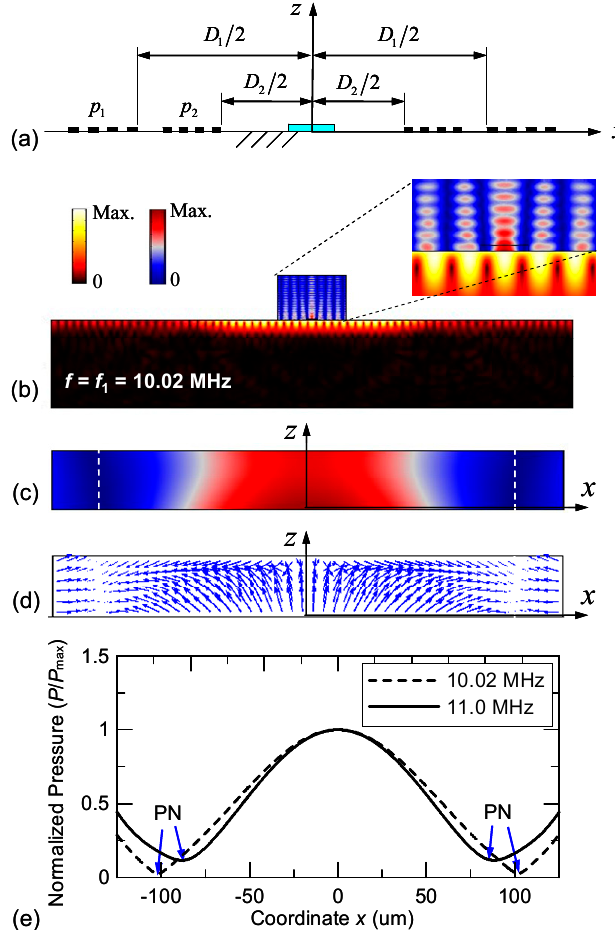
Figure 3. ( a ) Schematic of the symmetric two-pitch IDT arrangement on the surface of the LiNbO 3 substrate. The IDT pitches are p 1 = 398 µm and p 2 = 363 µm. Simulated results of ( b ) SSAW total displacement field and acoustic pressure field in the entire device generated by a driving voltage at 10.02 MHz and ( c ) normalized acoustic pressure field and ( d ) acoustic radiation force field in the water domain. ( e ) Comparison of the normalized acoustic pressure variations using 10.02 MHz and 11.0 MHz SSAW fields along the width direction of the water domain at z = 12.5 µm. (The acronym PN stands for “pressure node.”).